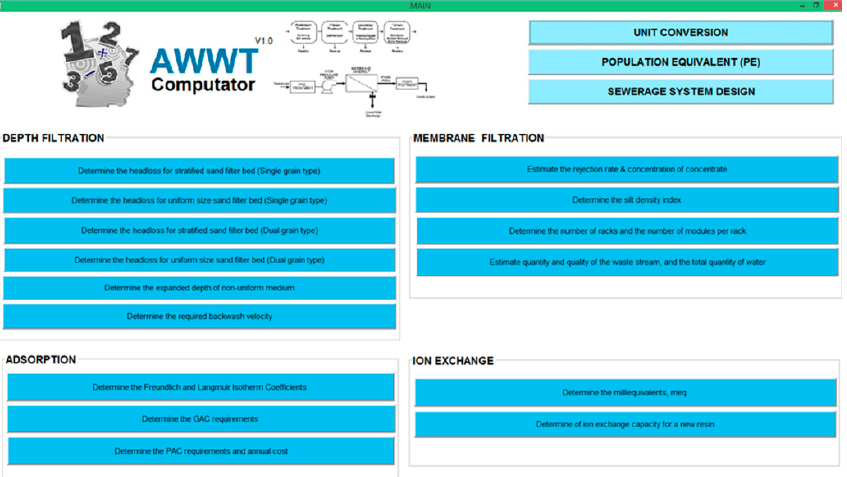
Figure 1. The main screen of the AWWTc computator.